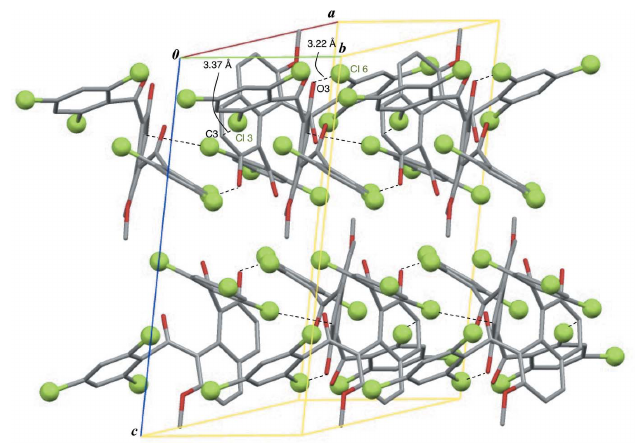
Figure 3 A view of the crystal packing of the title compound, showing the Cl (cid:2)(cid:2)(cid:2) O and Cl (cid:2)(cid:2)(cid:2) C short contacts. H atoms have been omitted for